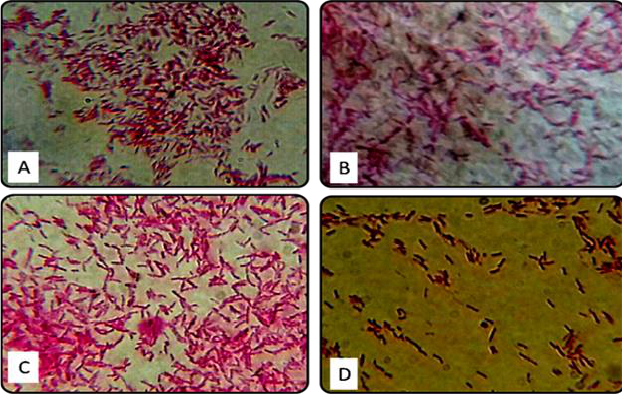
Figure 4. Acid fast bacilli, (A) M. fortuitum , (B) M. pallens , (C) M. neworleansense , (D) M . mucogenicum (